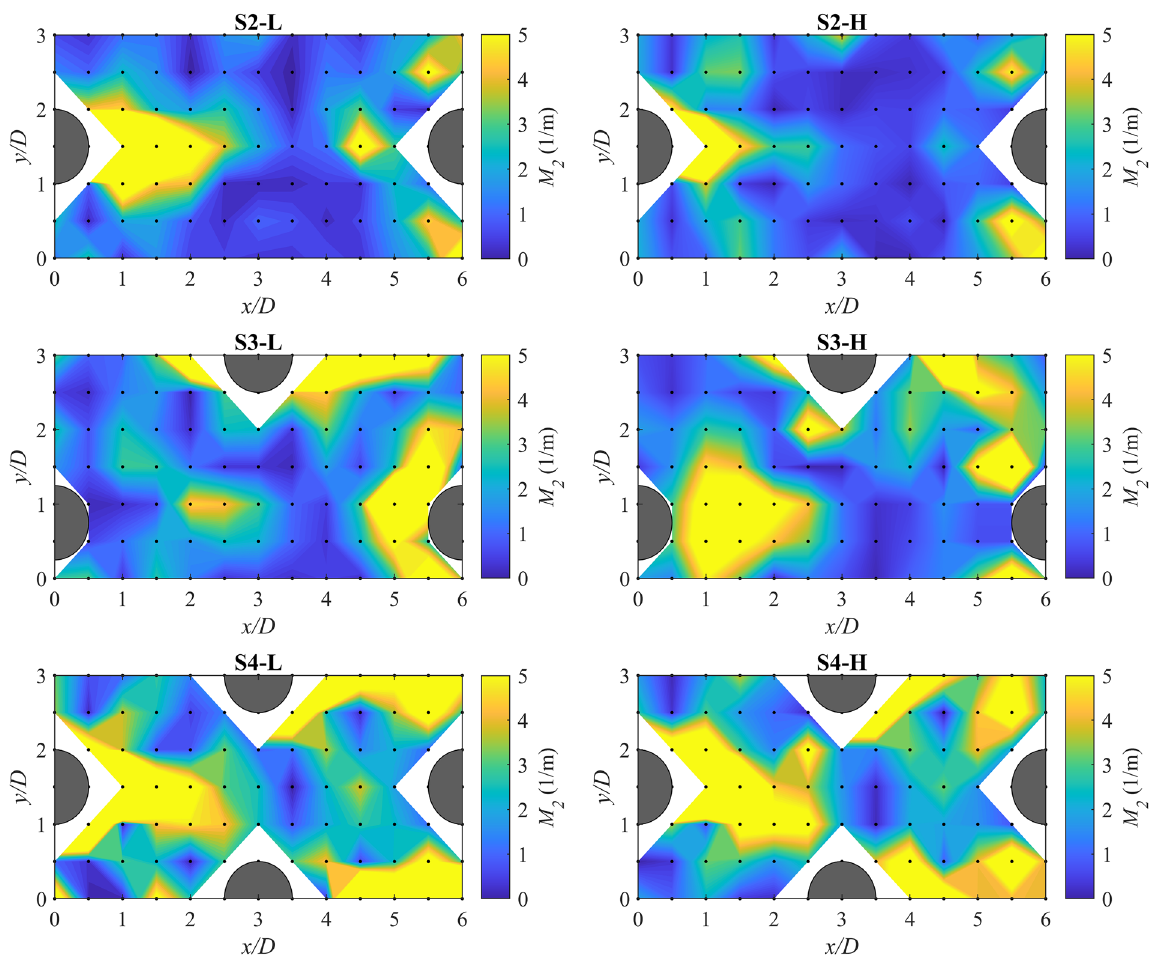
Figure 5. Contour maps of the normalized kinetic energy gradient metric, M 2 , for scenarios with boulder placement in the detailed measurement zone for Δ s = Δ x = 0.06 m. Black dots show the measuring station locations. The blank (white) areas in the contour maps are due to the missing measuring points occupied by